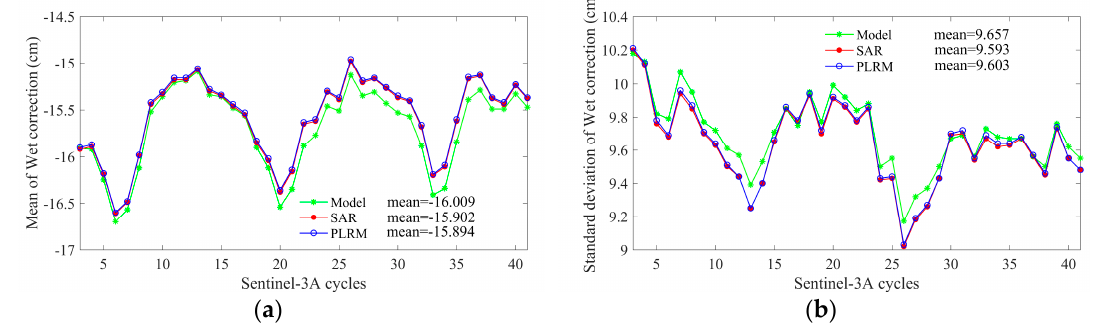
Figure 4. Cycle by cycle ( a ) means and ( b ) standard deviations of wet tropospheric corrections according to Sentinel-3A repeat cycles.